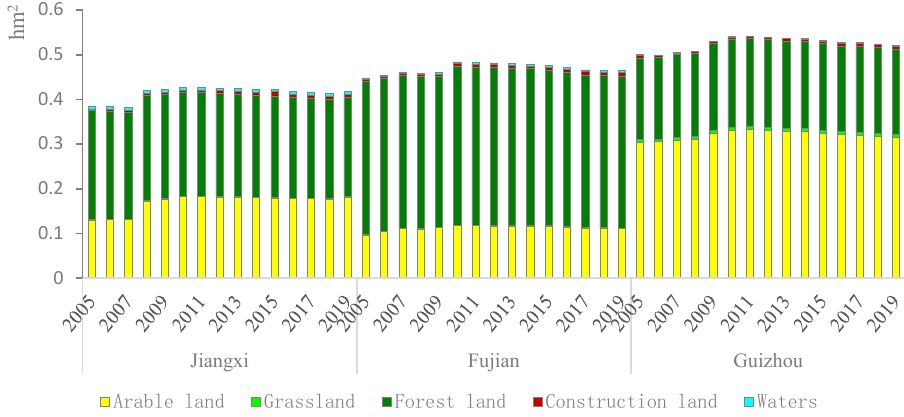
Figure 3. Per capita biocapacity in the National Pilot Zones for Ecological Conservation.